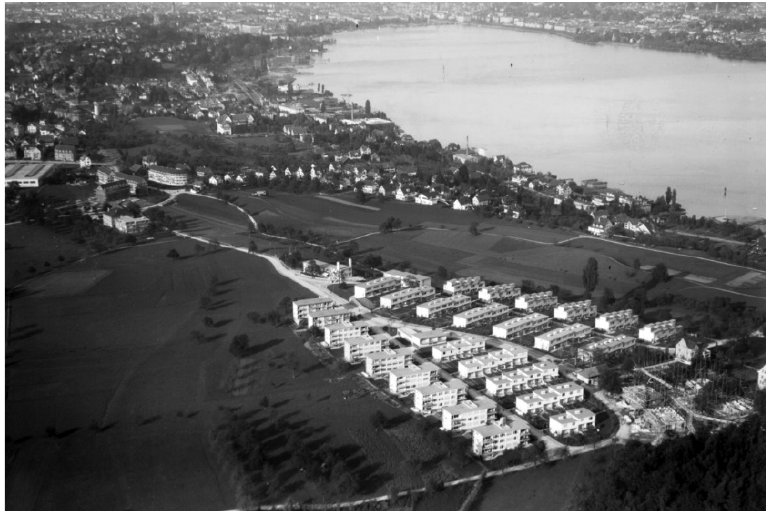
Figure 2. Neubühl housing settlement 1932, Zurich, by Swiss CIAM architects (originally published in Rationelle Bebauungweisen , 1931). This project was example #19 from the CIAM 3 proceedings. Source: Wikimedia Commons (2007).